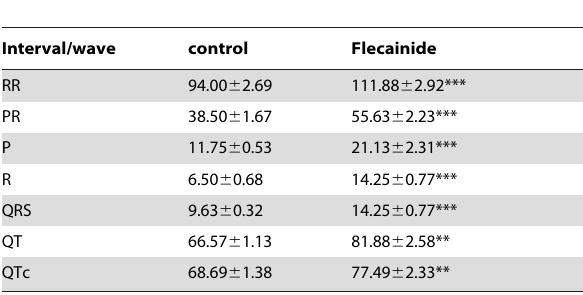
Table 4. Effect of the sodium channel blocker flecainide on the duration (ms) of P, R, and QRS waves and RR, PR, QT, and QTc intervals in Ts65Dn mice (N=